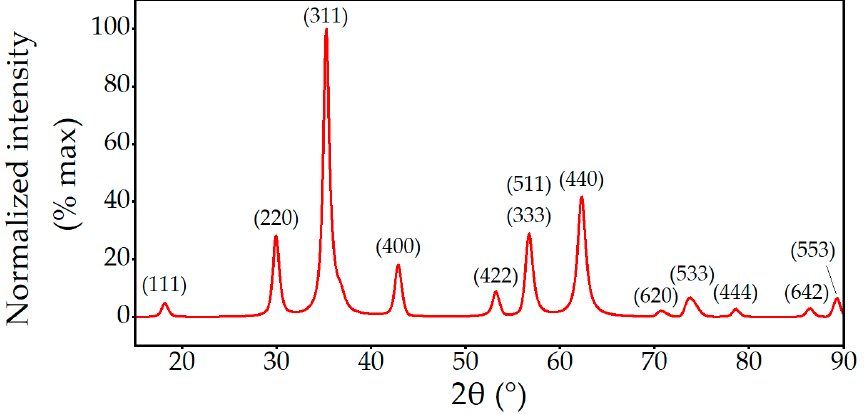
Figure 2. Background subtracted X-ray diffractogram of silicone-coated nanoparticles using Cu radiation. Labeled peaks are characteristic of a spinel structure with significant broadening due to particle sizes.